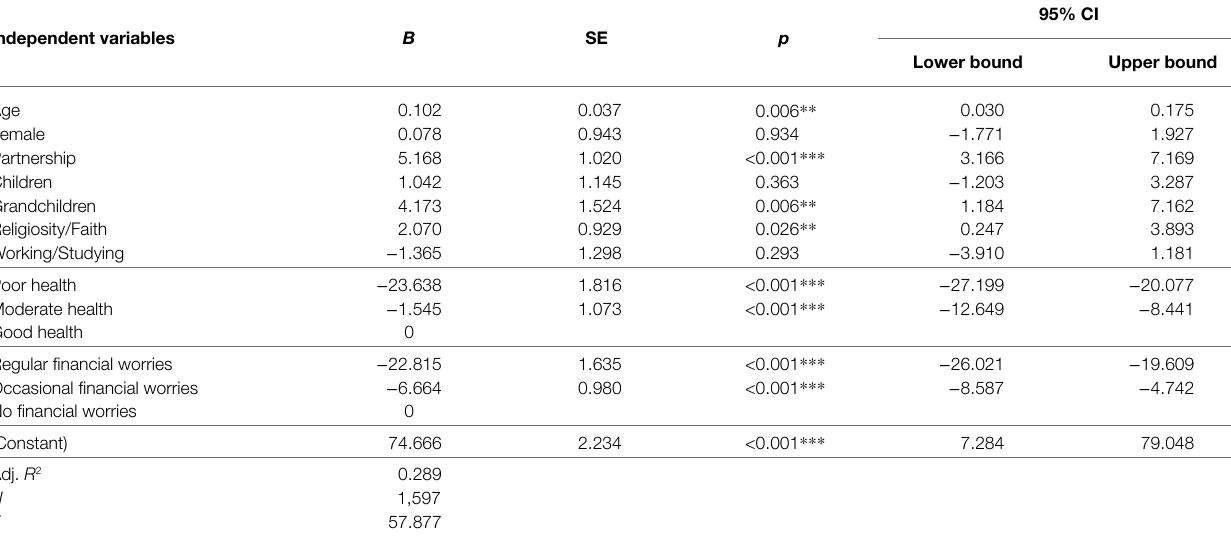
TABLE 4 | Regression of life satisfaction by socio-demographic variables.